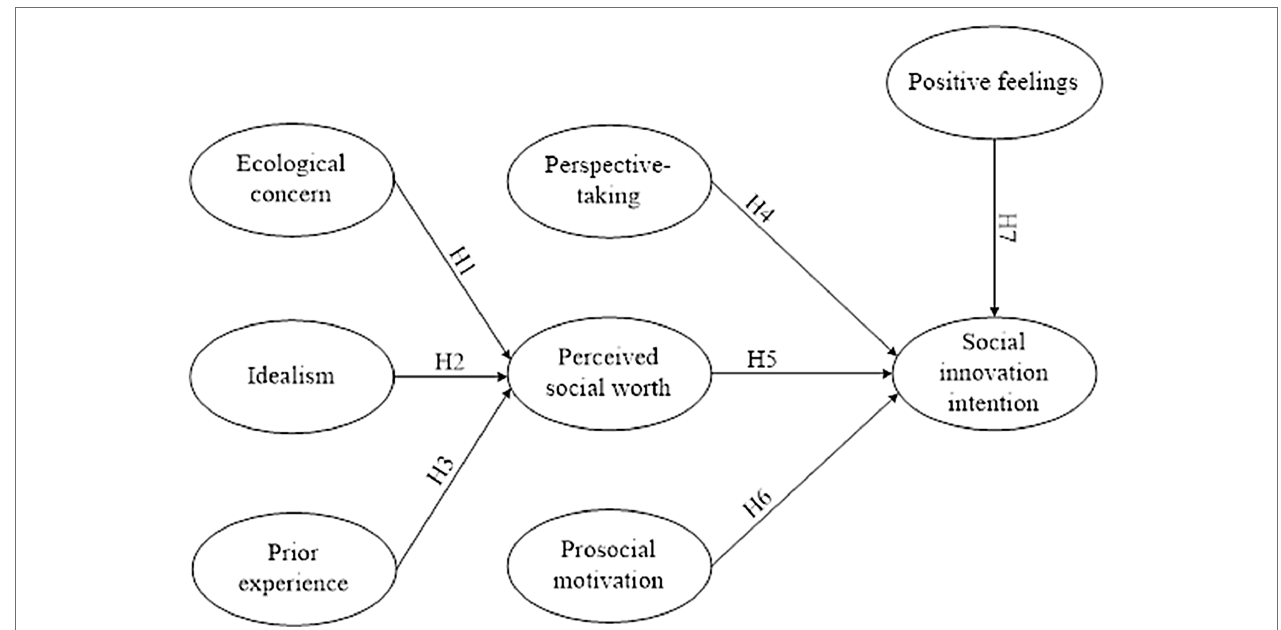
FIGURE 1 | Research